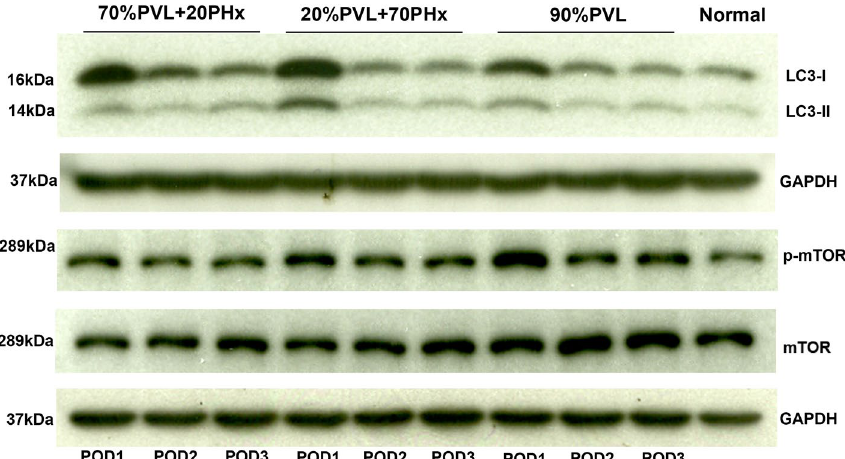
Figure 4. Autophagy related protein expression level in the non-ligated FLR after simultaneous PHx and PVL and PVL alone. Expression level of LC3 and mTOR of total liver homogenates of the FLR was investigated. Substantially higher level of LC3II was observed in additional large PHx and additional small PHx compared with PVL alone. The expression level of p-mTOR showed reverse results.